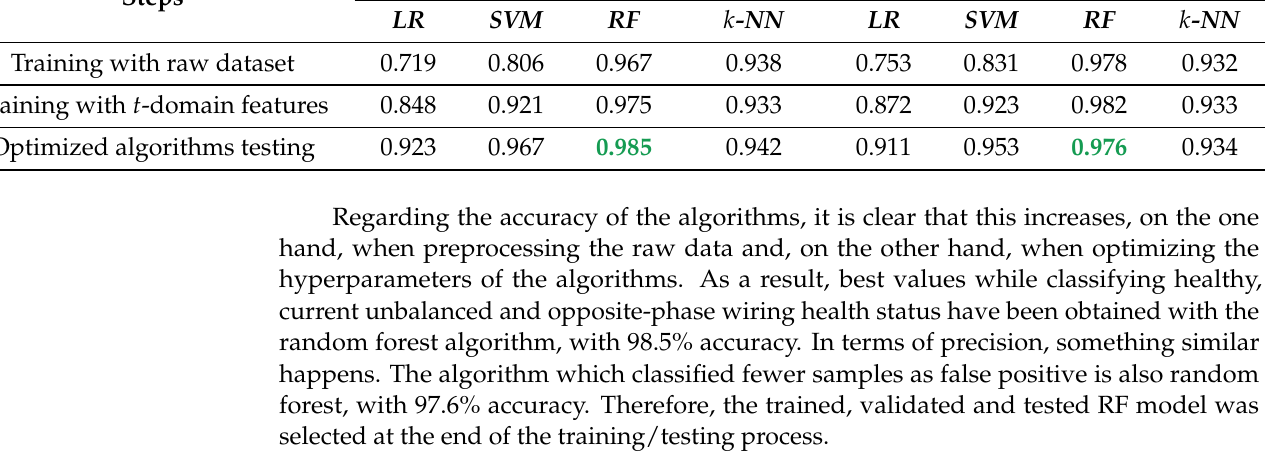
Table 3. Accuracy and Precision results of the different algorithms during different steps of the ML workflow.